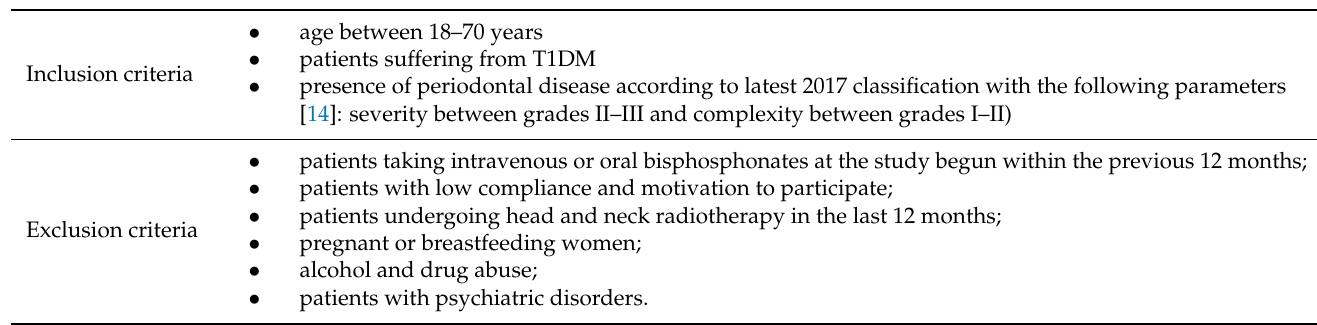
Table 2. Inclusion and exclusion